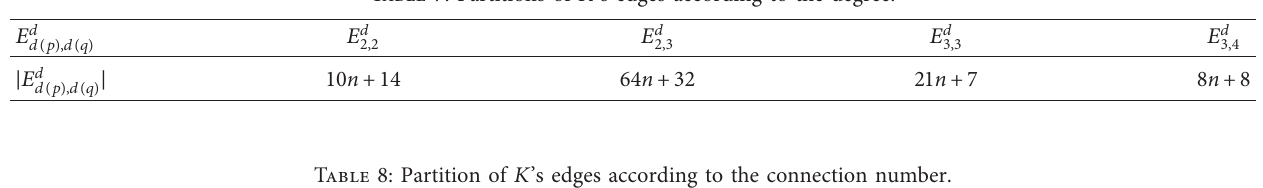
Table 7: Partitions of K ’s edges according to the